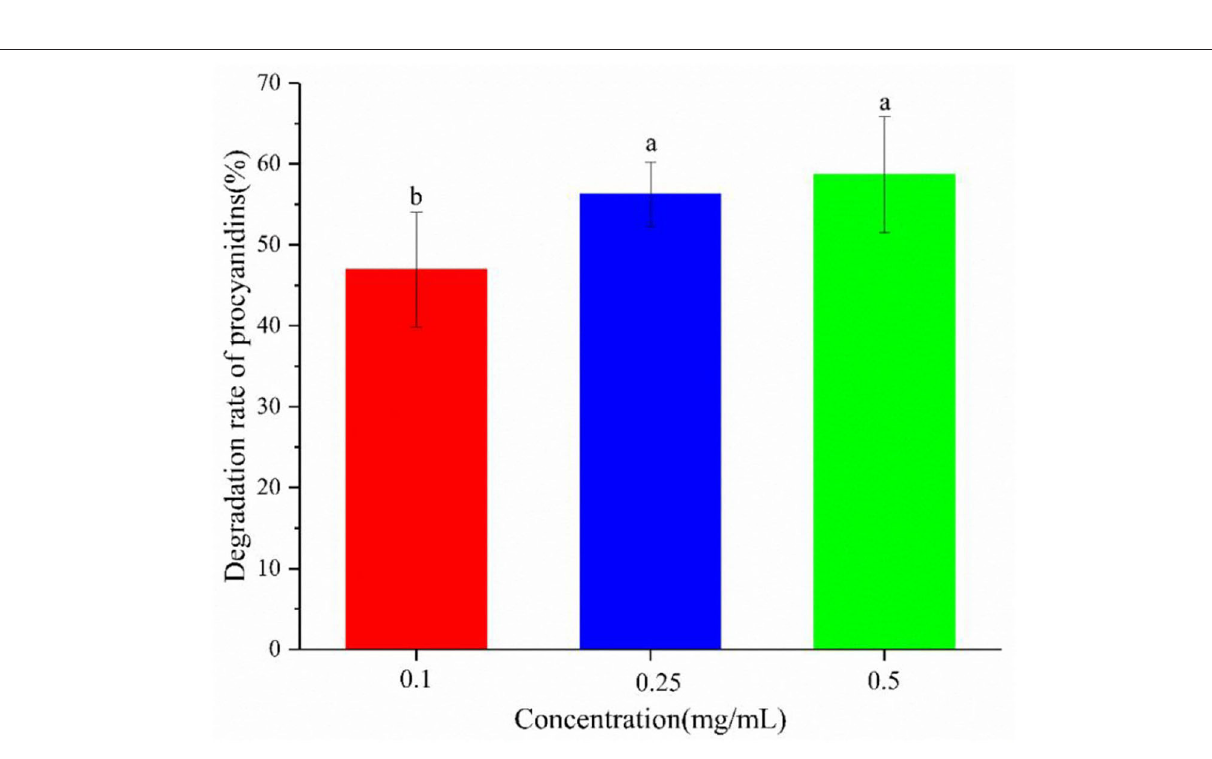
Frontiers in Nutrition |